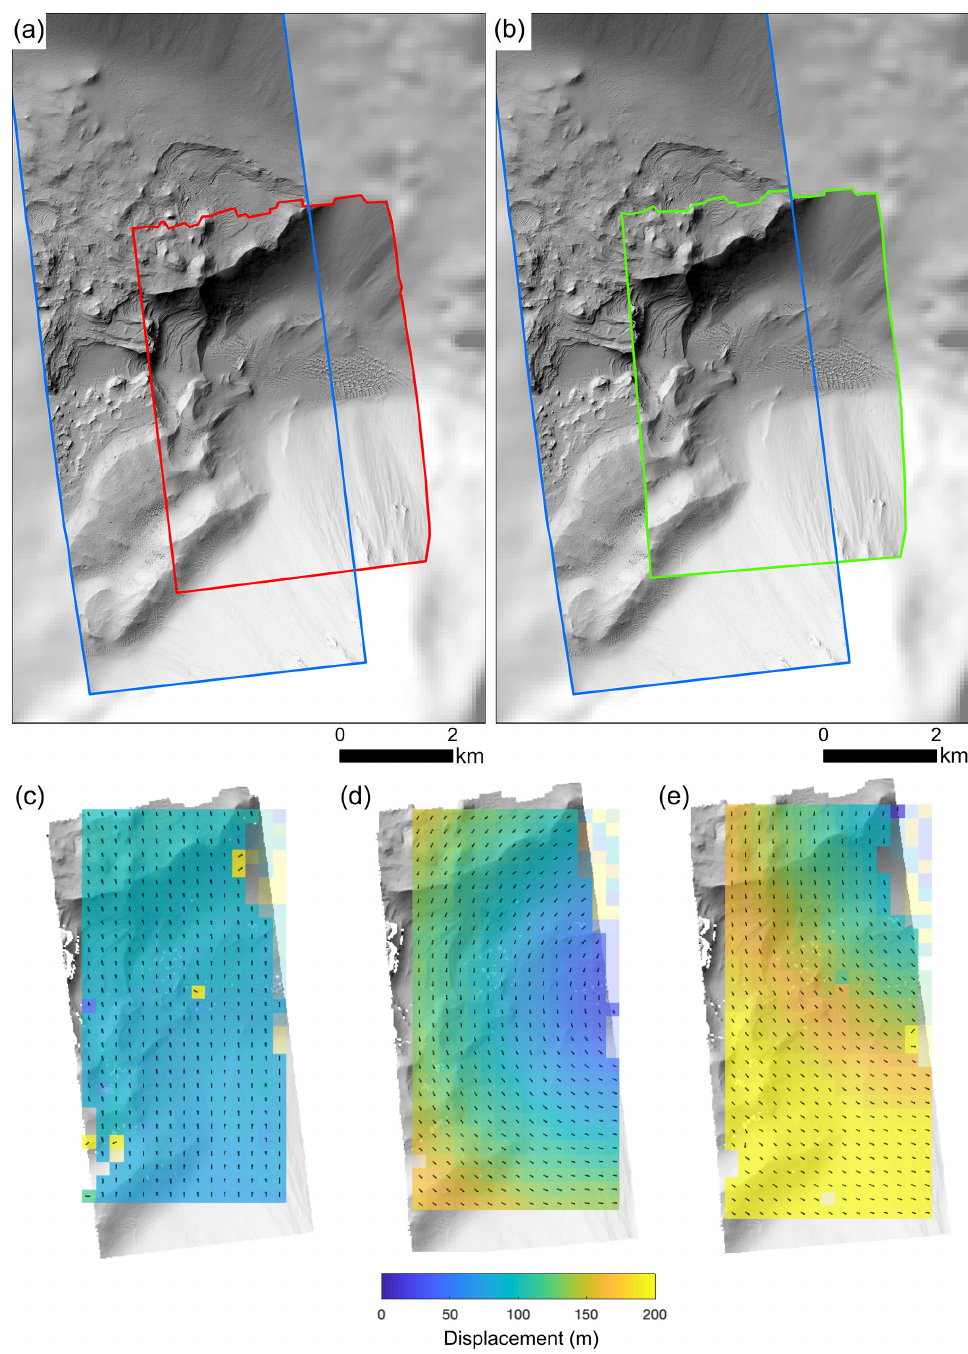
Figure 6. Alignment of site 2 DEMs including the AU DEM produced using the ASP pipeline presented, the PDS DEM (DTEEC_003910_1685_005400_1685_U01: https://bit.ly/2tQr89U, last access: 10 February 2019), and the HRSC DEM (h1999_0000_da4). (a–b) Hillshaded PDS DEM (blue box), the AU DEM 3 pre-pc_align (red box), and AU DEM 3 post-pc_align (green box). Background is the hillshaded HRSC DEM. Note the misalignment between AU and PDS DEMs. (c) Displacement between the AU ( pre-pc_align ) DEM and the PDS DEM. Little displacement indicates strong agreement. (d) Displacement measured between the two AU DEMs. (e) Displacement between the AU ( post-pc_align ) DEM and the PDS DEM. Note the strong rotational component to displacement as the AU DEM shifts to better match the HRSC DEM. Panels (c–e) created using the ImGRAFT feature tracking algorithm (Messerli and Grinsted,